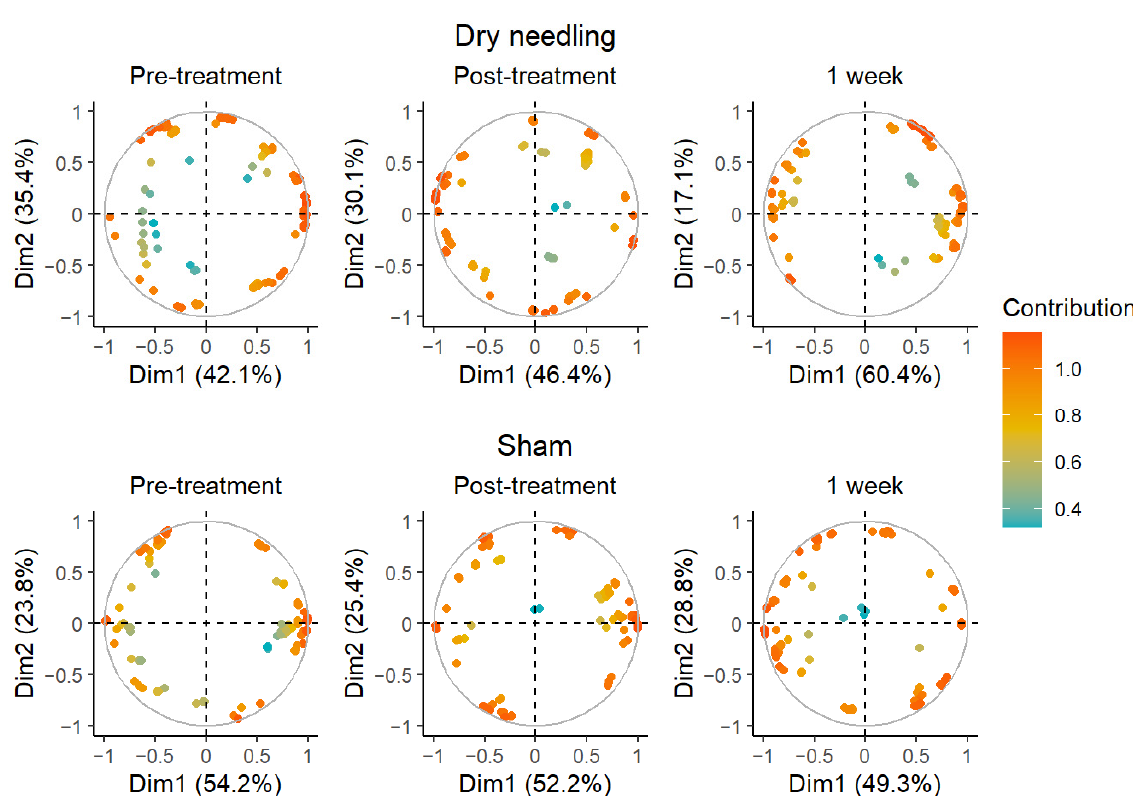
Figure 4. Graphic of variables .